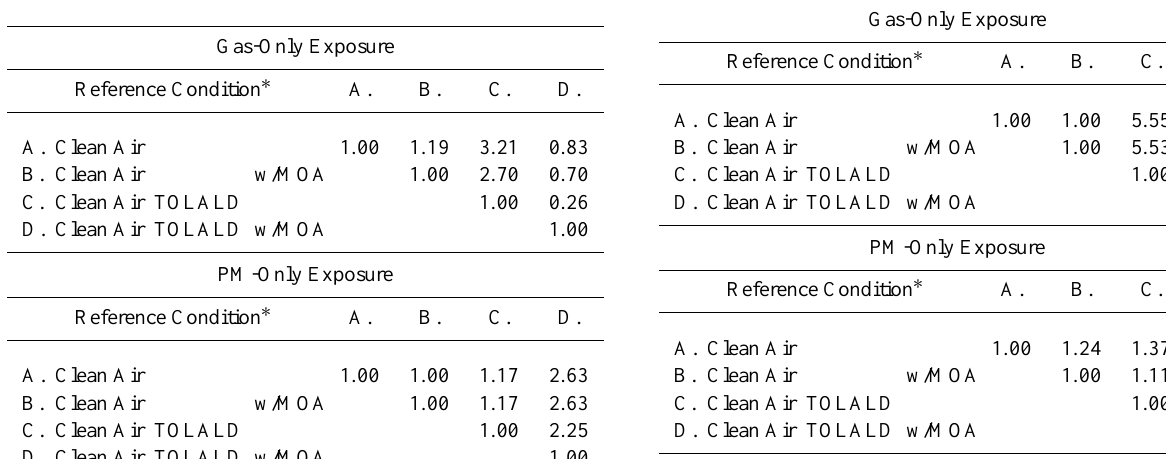
Table 3. Ratios of measured cellular damage (LDH) for in vitro hu- man lung cell exposures to TOLALD mixtures, (Table 1 and Fig.